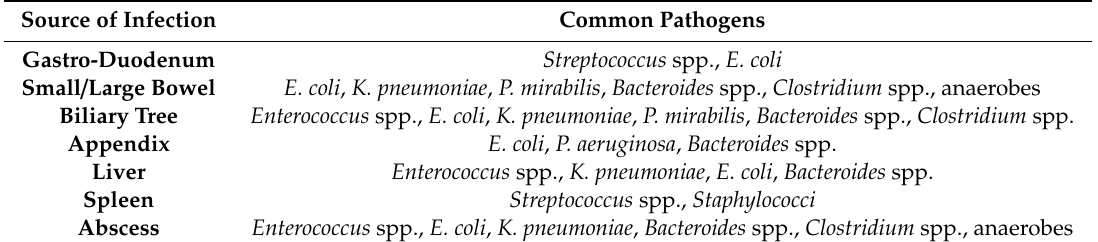
Table 1. Common bacterial pathogens stratified by anatomic region of source for empiric treatment reference